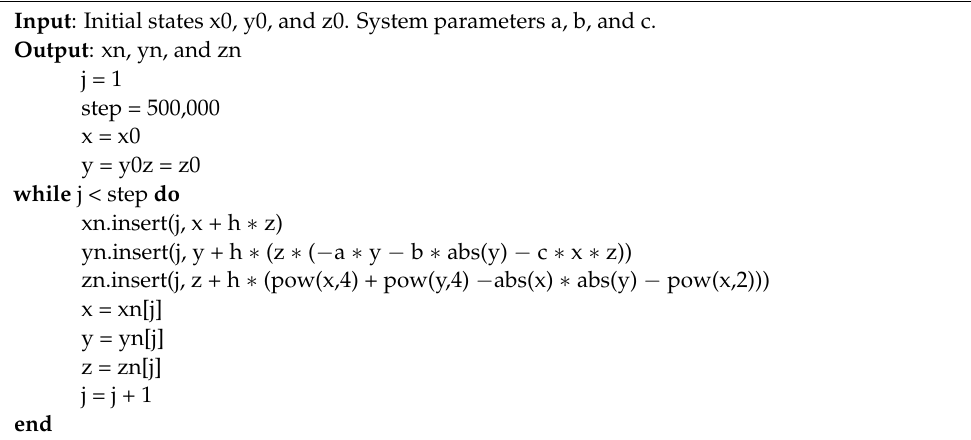
Algorithm 1 Python code for the new discrete-time chaotic system (9)